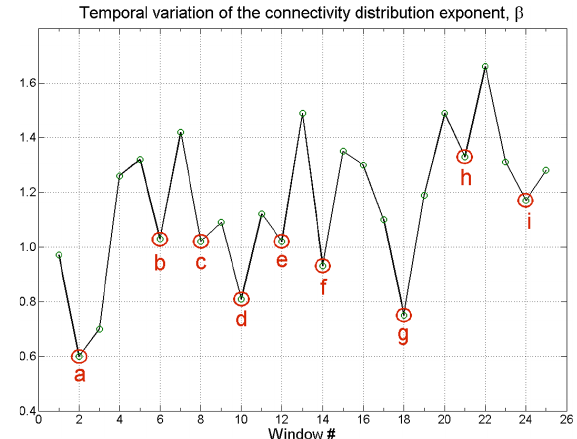
Fig. 10. Exponent of connectivity distributions for networks M1–M6.